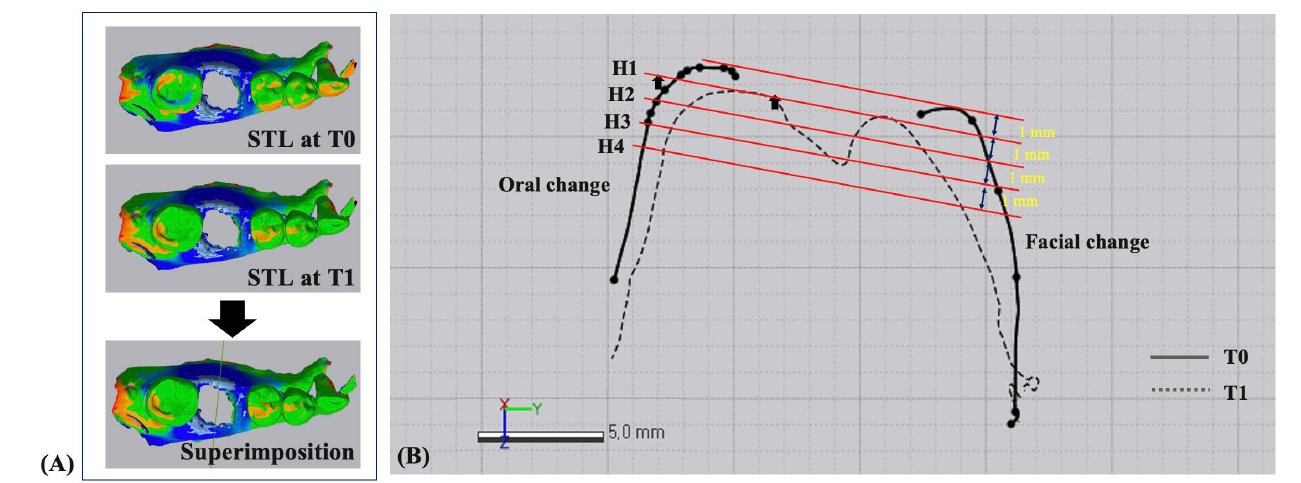
Figure 2. Superimposition and measurement. ( A ) Standard tessellation language file acquisition and superimposition using the best-fit alignment process, ( B ) measurement on the superimposed tissue surfaces.